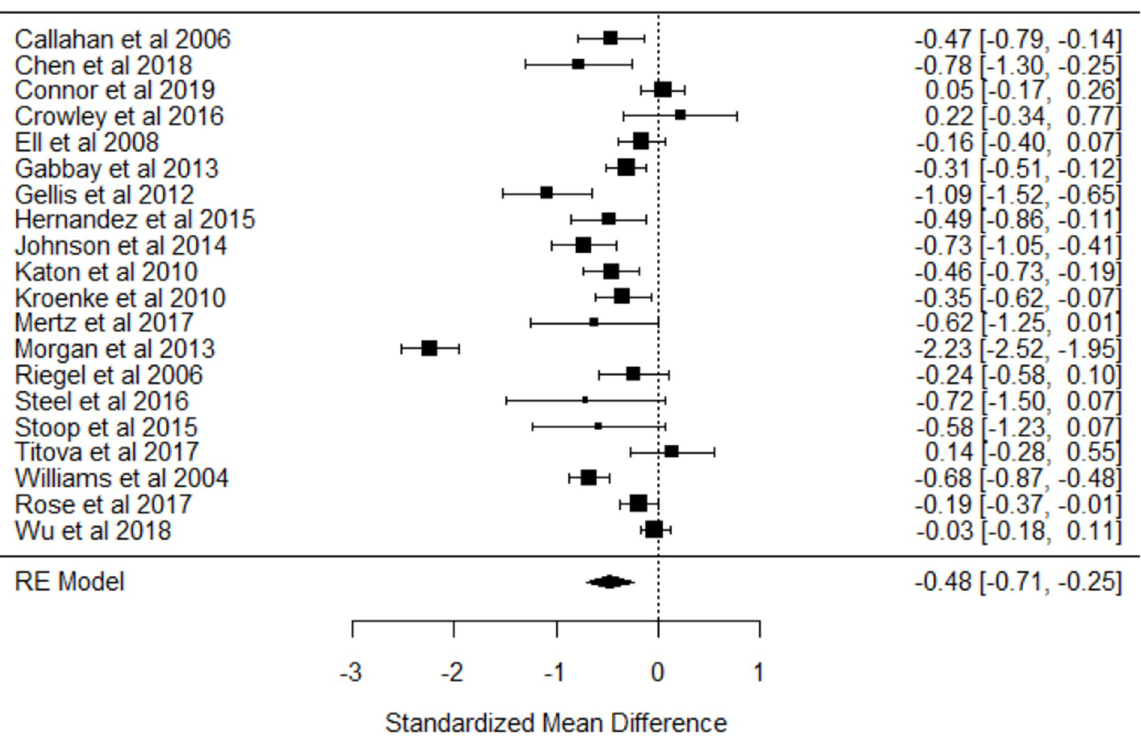
Fig 3. Forest plot on the effect of case management interventions on depressive symptoms (random-effects